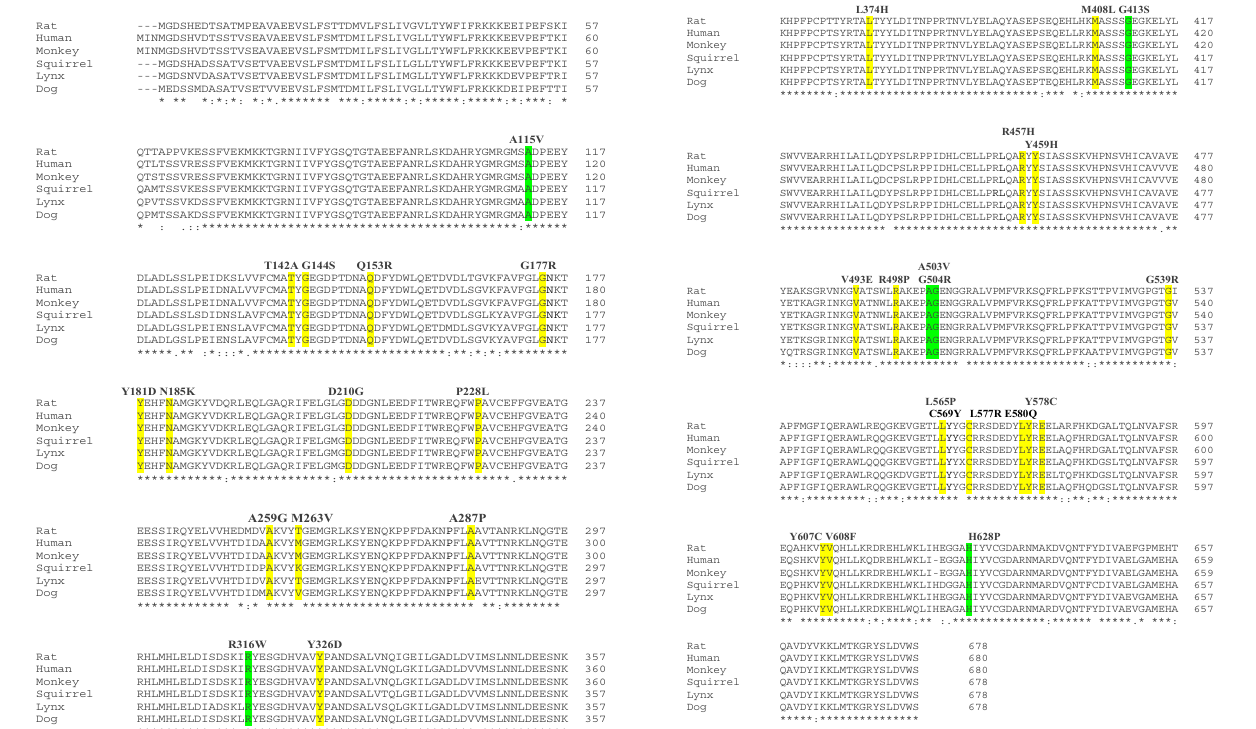
Figure 6. Multiple protein sequence alignment of human and other POR orthologs. The protein sequences used include: rat (NCBI: NP_113764.1), human (NCBI: NP_000932.3), monkey (NCBI: XP_024105393), squirrel (NCBI: XP_006155694.1), lynx (NCBI: XP_046945282.1), and dog (NCBI: NP_001171276.1). The Clustal Omega multiple sequence alignment tool was utilized to make the alignments above. Residues that are highly conserved within the five species are labelled. Polymorphic variants found in healthy individuals are highlighted in green, while the mutation variants found in PORD patients are highlighted in yellow.